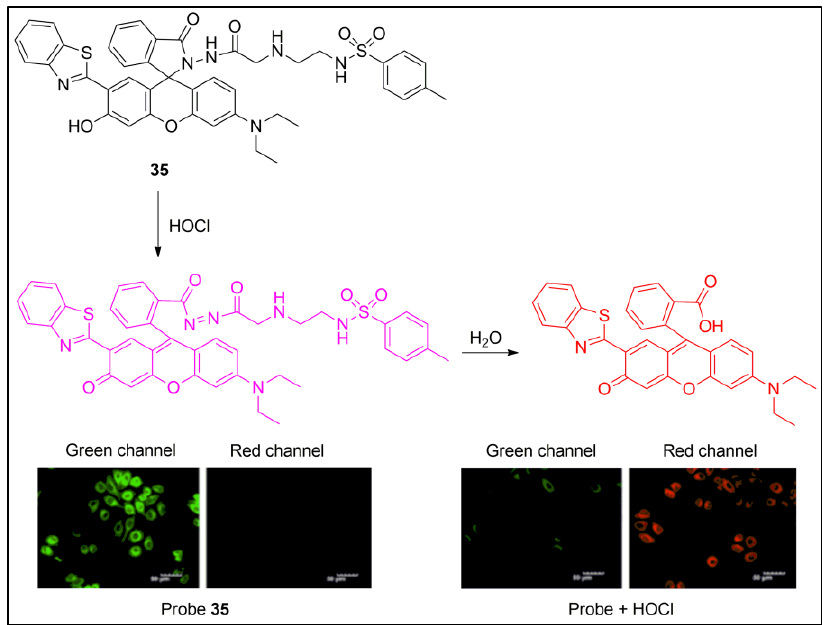
Figure 35. Response mechanism of probe 35 to HOCl. Confocal images of 35 responding to HOCl in HepG2 cells. HepG2 cells were incubated with 35 (10.0 μ M) for 15 min prior to incubating with HOCl (20 equiv.) for 15 min. Adapted with permission from [113]. Copyright (2022) Elsevier.